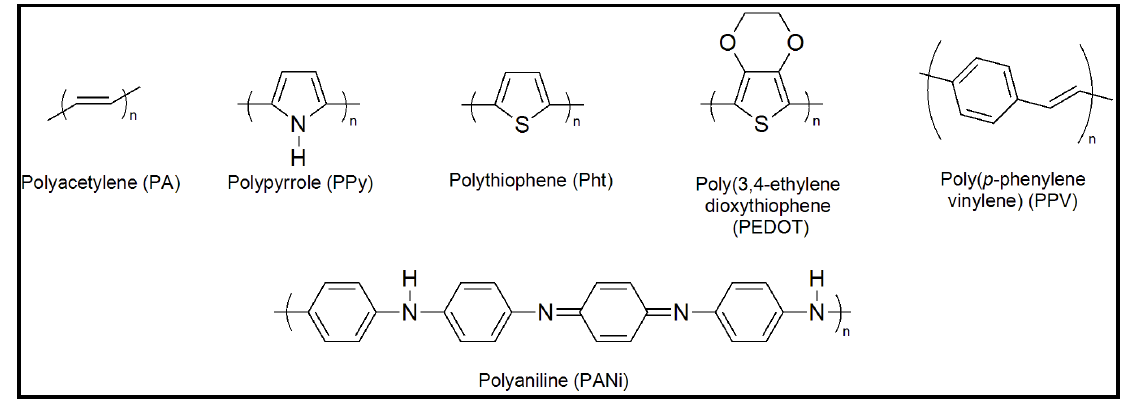
Figure 2. Scheme showing the chemical structure of main conducting polymers.